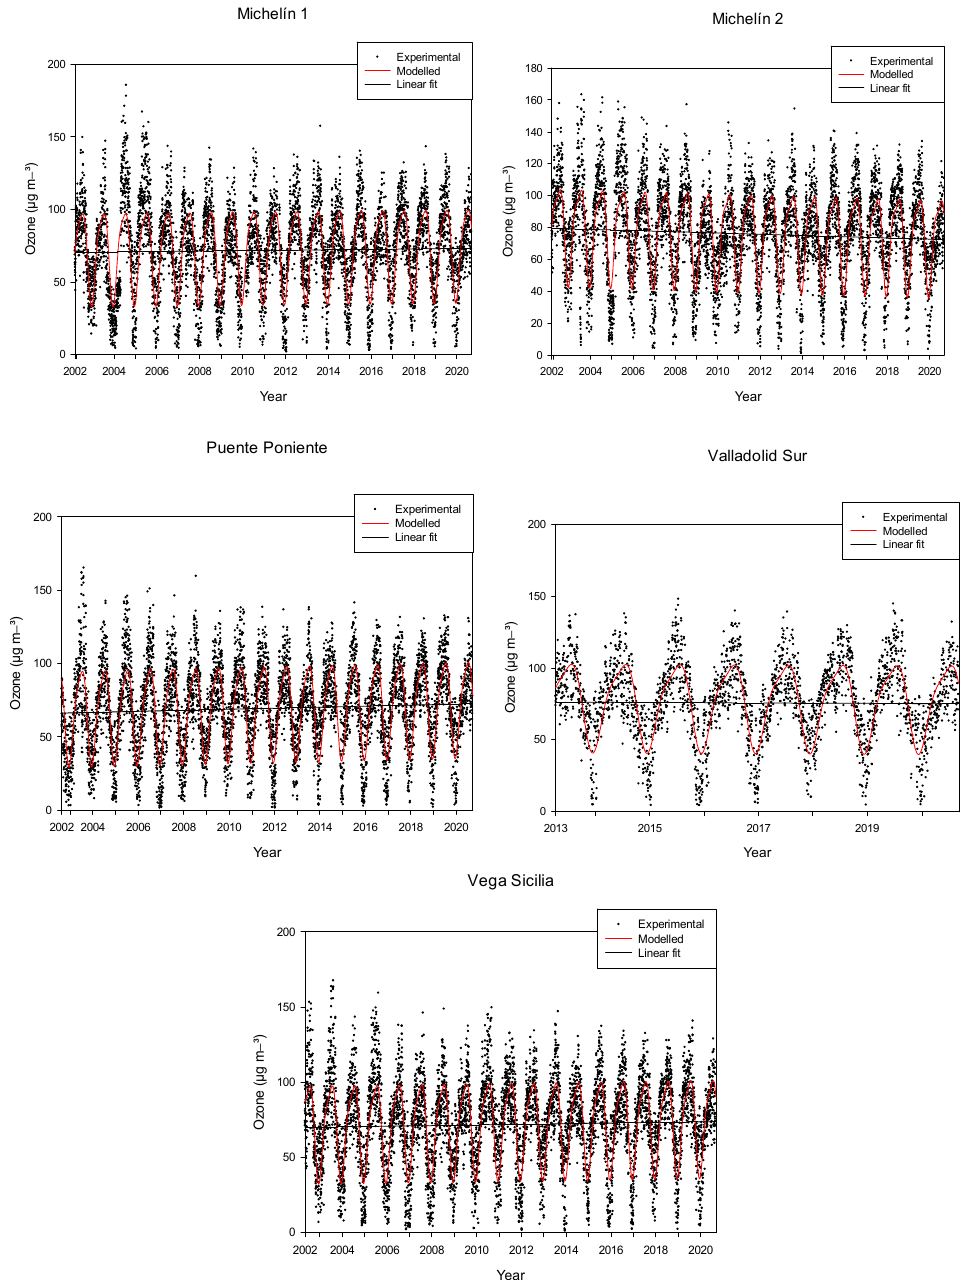
Figure 6. Evolution of the maximum daily 8 h average ozone concentrations in the study period.